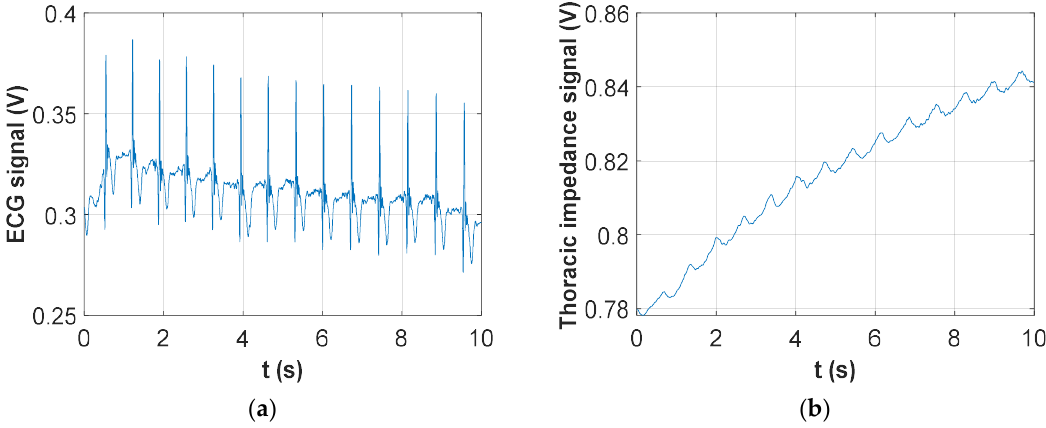
Figure 5. Processed signals from the instrumentation amplifier output: ( a ) Low-pass filtered signal; ( b ) Envelope detection on the high-pass filtered and rectified signal.